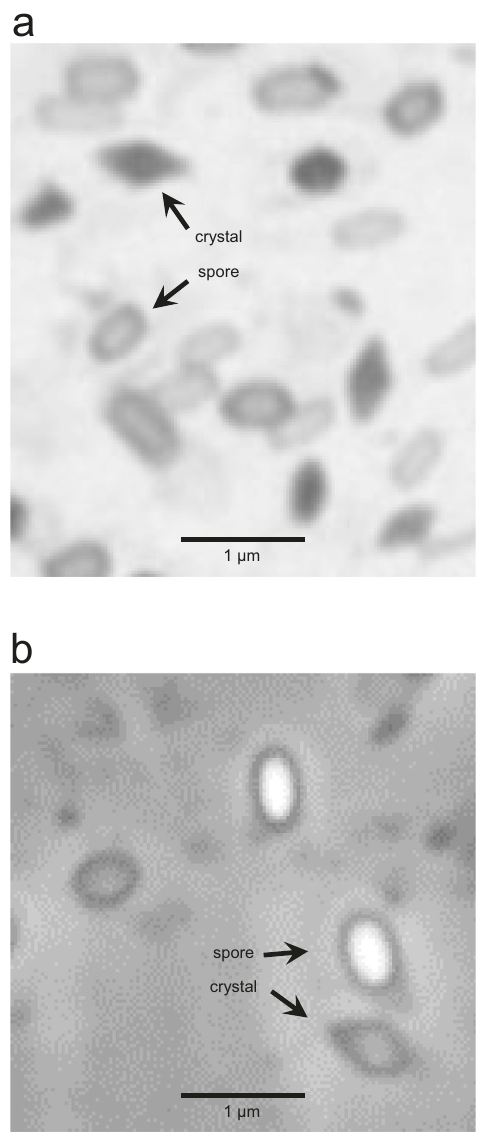
Fig. 2 Micrographs of bacterial cultures, taken with a ×100 oil immersion lens. Cultures were grown and observed microscopically fi ve times each, and similar results were seen each time. Photographs were taken once. a Sporulated native Bacillus thuringiensis ( Bt ) strain after autolysis, stained with Coomassie. Crystals are stained dark, while spores remain light. b Sporulated plasmid-cured Bt strain expressing Cry14Ab, after autolysis. Source data are provied as a Source Data fi